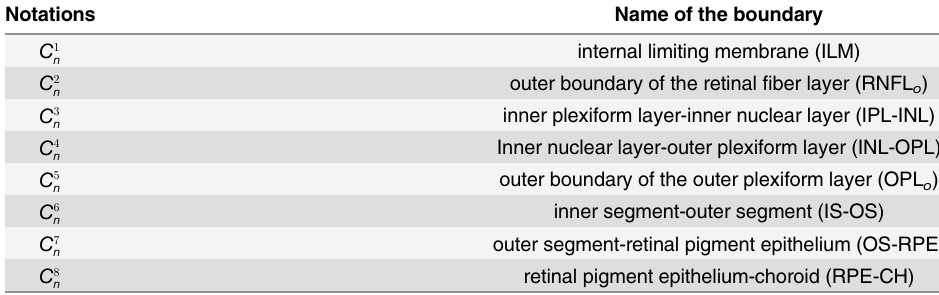
Table 1. Notations for eight target boundaries, n denotes the frame